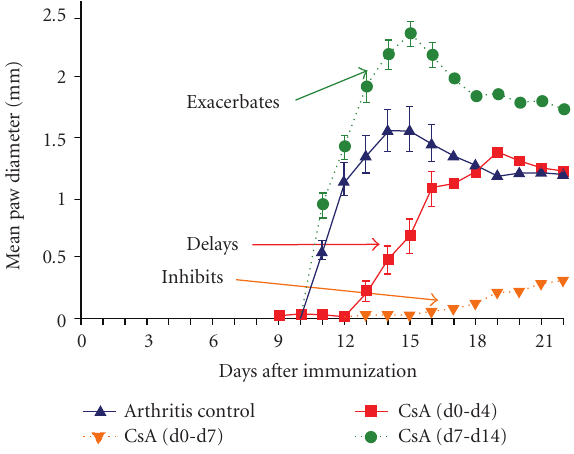
Figure 8: The e ff ect of cyclosporin A (CsA), a potent immunosup- pressant, on the extent of collagen-induced arthritis (CIA) in young adult, female Lewis rats depends on the treatment schedule. The course of CIA in untreated animals (arthritis control) is represented by the solid blue line with triangular data points. Administration of CsA on the day of arthritis induction (designated as d0) for 7 consecutive days (d0 to d7) substantially inhibits hind paw swelling (orange-dotted line with inverted triangles). Early but abbreviated treatment with CsA (d0 to d4) delays disease onset but does not impact its ultimate severity (solid red line with squares). Delayed exposure to CsA (d7 to d14) greatly exacerbated the degree of hind paw swelling (green-dotted line with circles). Bars associated with data points represent standard error of the mean. Treatment regimen: CsA was given at 25mg/kg/day by